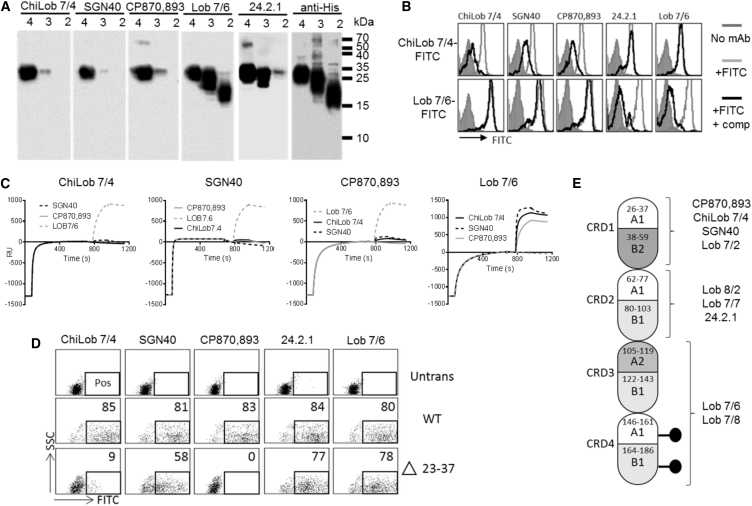
Epitope Mapping of Anti-hCD40 mAbs(A) C-terminally His-tagged CD40 proteins consisting of 4, 3, or 2 CRD domains (4 = full-length; 3 = CRD1 deleted; 2 = CRD1 and CRD2 deleted) were analyzed by western blotting with the mAbs indicated above each panel used for detection. A composite image from multiple blots with different antibodies is shown.(B) hCD0Tg mouse B cells were incubated with FITC-labeled Lob 7/4 or Lob 7/6, as indicated, in the absence or presence of a 10-fold excess of competitor (comp) mAbs indicated above each plot. Cell labeling was assessed by flow cytometry; filled histogram, unlabeled cells; light gray, FITC-labeled mAbs alone; black line, FITC-labeled mAbs + competitor.(C) Surface plasmon resonance analysis of mAb competition for CD40 binding. The mAbs indicated above each plot were flowed over immobilized hCD40 ECD for 800 s to allow saturation of hCD40 binding sites, followed by the addition of individual competitor mAb for 350 s. Non-competitive mAbs (i.e., mAbs without overlapping epitope) give a response greater than 500 response units (RU).(D) Untransfected 293 cells (none), or cells transfected with full-length (WT) human CD40 or CD40 in which N-terminal amino acids 23–37 had been deleted, were incubated with the indicated anti-hCD40 mAbs (h2 isotype). Bound mAbs were detected with anti-human Fc-FITC. The percentage of cells in the boxed region, denoting positive staining, is shown for each plot. Results from one of two experiments shown.(E). Schematic of the approximate locations of epitopes for nine human CD40 mAbs analyzed. See also Figure S1.